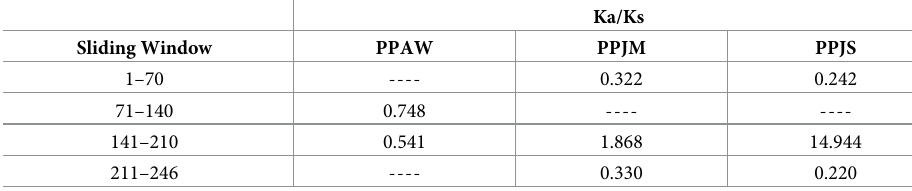
Table 7. PpSP14 sliding window analysis.